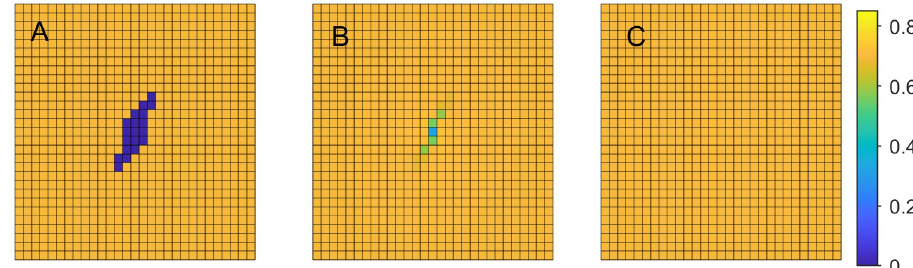
Fig 7. Tissue regeneration under normoxic conditions. Cellular volume fraction u 1 at time steps t = 1, 11, 21. A: time step t = 1, B: time step t = 11, C: time step t = 21.